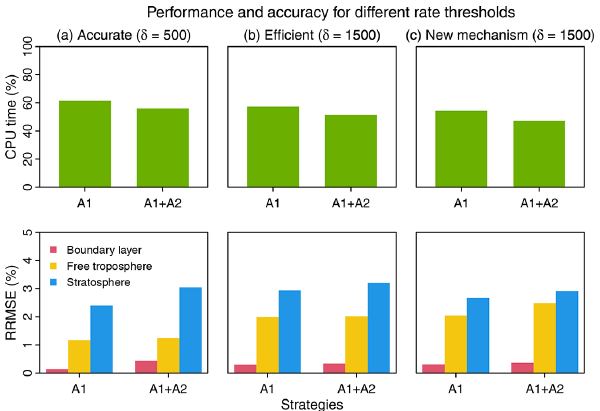
Figure 6. Performance and accuracy of the adaptive chemical mechanism. We test the performance of the adaptive method by (A1) removing slow species ( P i or L i > δ ) and (A2) removing slow reactions (reaction rate < 10 moleculescm − 3 s − 1 ). Results are shown on the last day of 3-year simulations. The unit of δ is moleculescm − 3 s − 1 . The performance is measured by the comput- ing processor unit (CPU) time used by the chemical operator, and the accuracy is measured by the median relative root mean square error (RRMSE) for species concentrations using the full chemi- cal mechanism in the boundary layer (0–2km altitude), free tropo- sphere (2km to tropopause), and stratosphere. For (a) and (b) , we use δ as 500 and 1500 moleculescm − 3 s − 1 in GEOS-Chem 12.0.0, which has 228 species and 724 reactions. For (c) , we port the algo- rithm to GEOS-Chem 12.9.1, which has 262 species and 850 reac- tions. The number of blocks ( N ) is 13 and the number of chemical regimes is 21 (20 submechanisms ( M = 20) and 1 full mechanism).